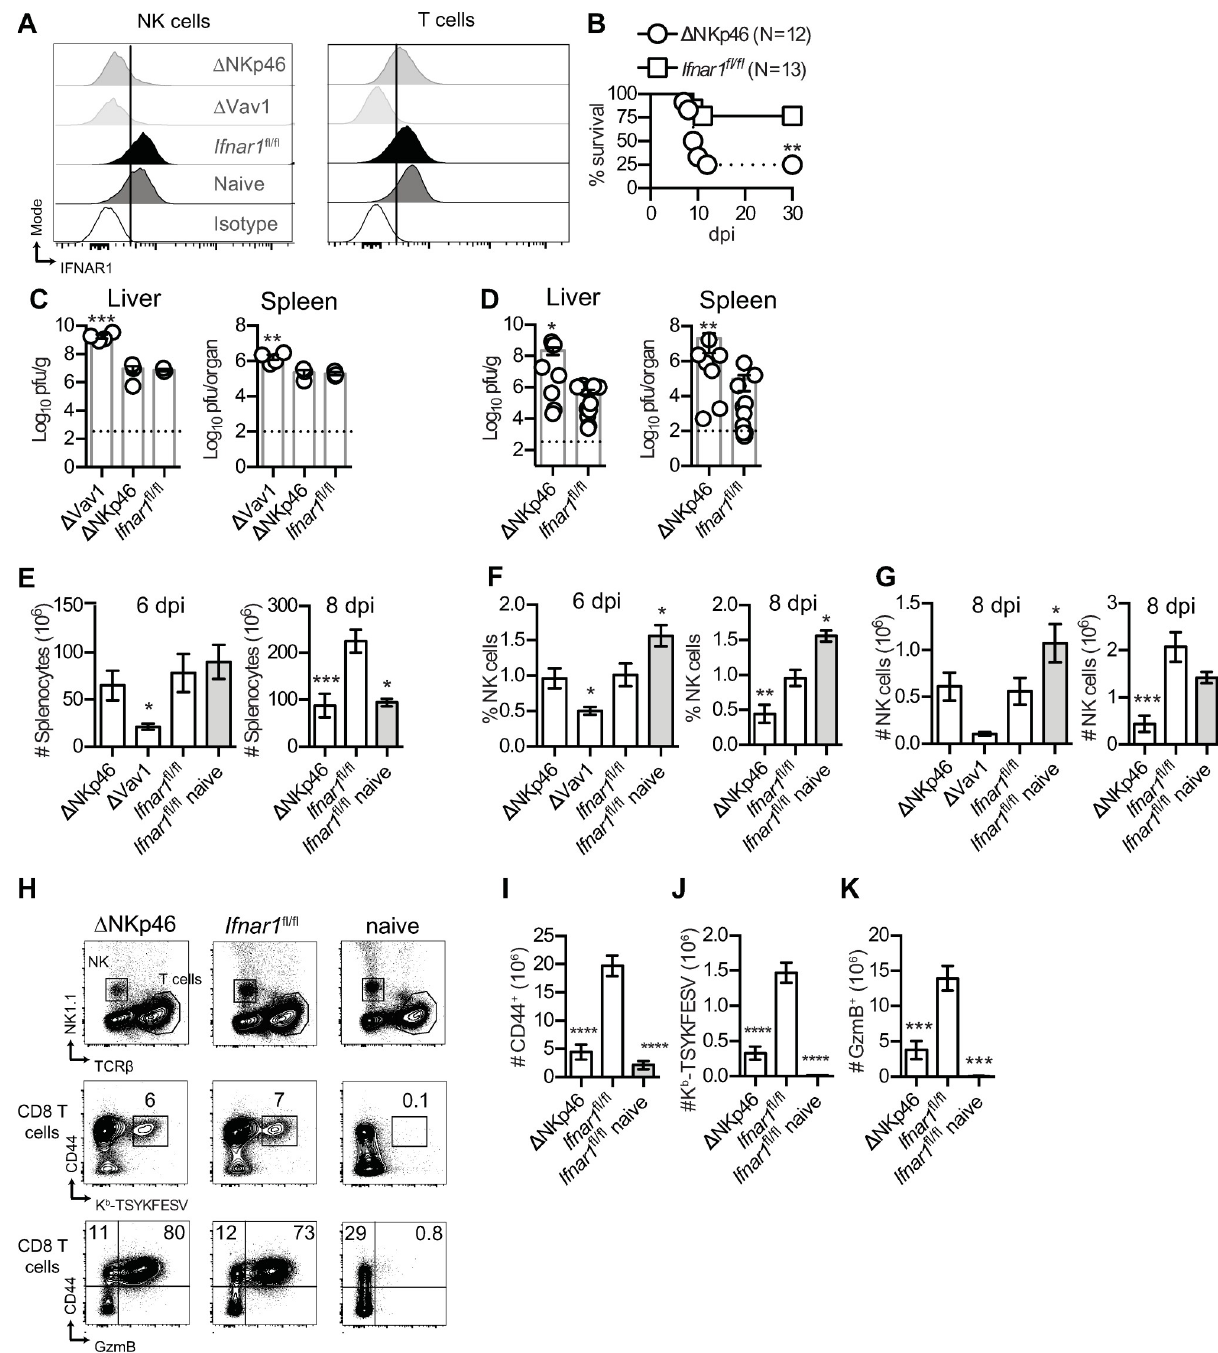
Fig 4. IFNAR on NK cells is essential for resistance to mousepox (A) Concatenated histograms showing IFNAR1 expression in gated NK (NK1.1 + TCR β - ) or T (NK1.1 - TCR β + ) cells from spleens of the indicated infected (6 dpi) mice or of Ifnar1 fl/fl na ï ve mice. Concatenated histograms are derived from one independent experiment (N = 3 or four mice for each group). (B) Survival of the indicated mice infected with 3000 pfu of ECTV-GFP in the footpad. Data pooled from two independent experiments (Log-rank Mantel-Cox compared to Ifnar1 fl/fl mice). (C-D) ECTV titers the livers and spleens of the indicated mice were quantified by plaque assay at six (C) and eight dpi (D) . The dashed line indicates the detection limit. (E-G) Number of live splenocytes (E) , frequency of NK cells (F) and numbers of NK cells (G) in the spleens of na ï ve and indicated infected mice at 6 and 8 dpi. (H) Concatenated flow cytometry plots showing NK and T cells gating and CD44 expression, K b -TSYKFESV-specific and GzmB expression in CD8 T cells from spleens of Ifnar1 fl/fl na ï ve mice and indicated infected mice at 8 dpi. (I-K) Number of antigen experience CD44 + (I) , of CD44 + K b -TSYKFESV + (J) and of CD44 + GzmB + (K) CD8 T cells in the indicated mice at 8 dpi. Data are represented as mean ± SEM from two pooled independent experiments (N = 9 or 10 for each group, ANOVA with Tukey correction compared to Ifnar1 fl/fl infected mice). https://doi.org/10.1371/journal.ppat.1009593.g004 PLOS Pathogens| https://doi.org/10.1371/journal.ppat.1009593 May 20,